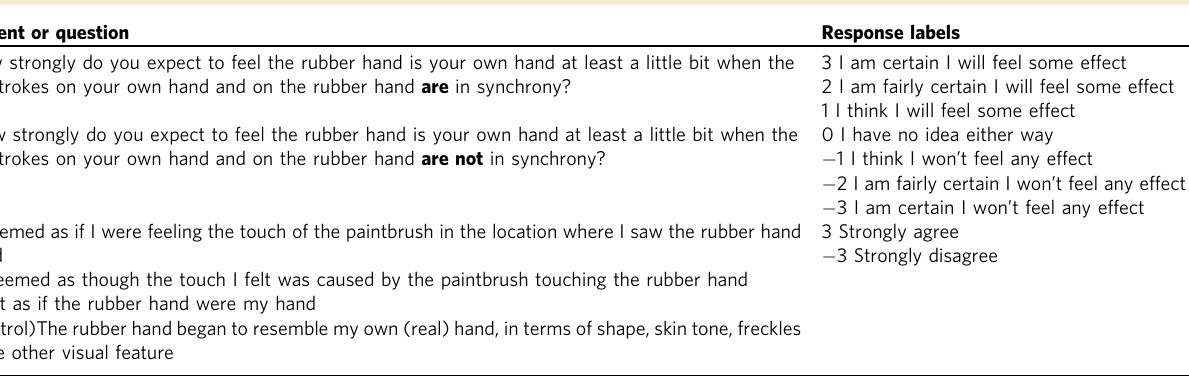
Table 1 Statements, questions and response labels used to generate subjective report scores for expectancies and illusion